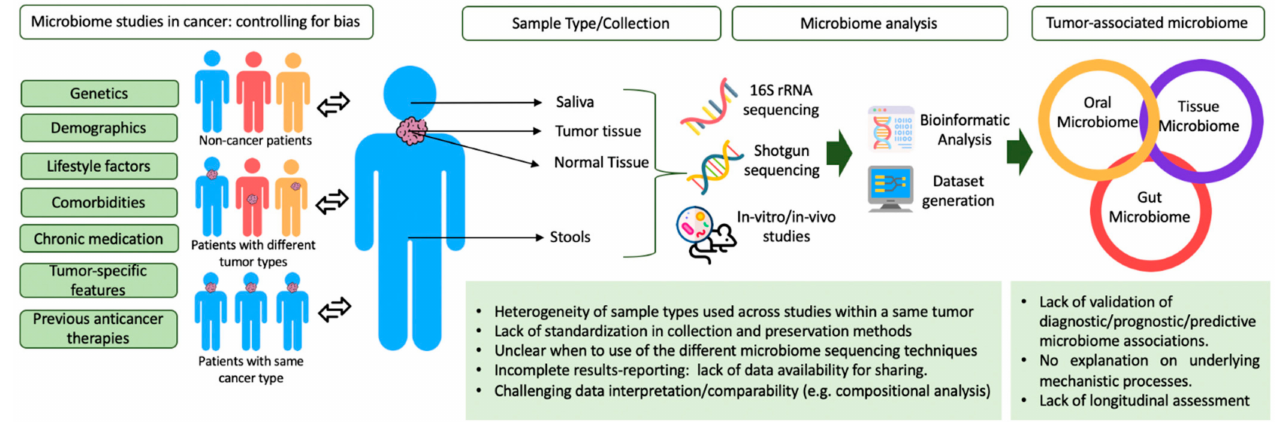
Figure 2. Challenges of microbiome studies in